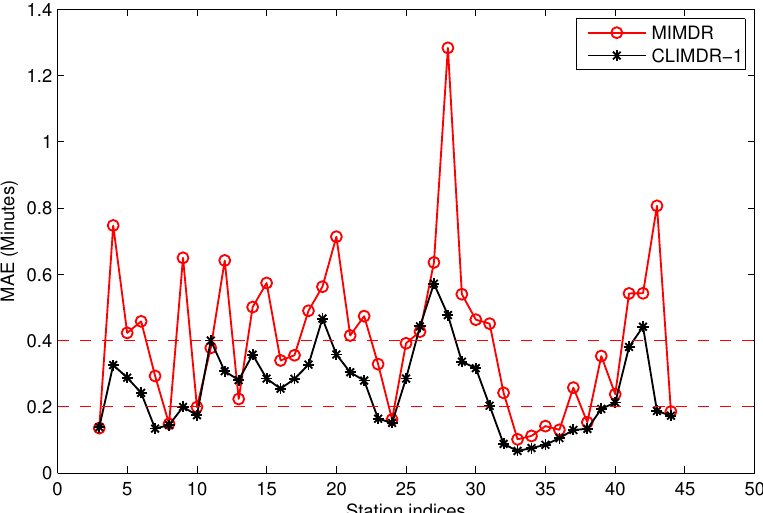
Figure 20. The MAE performance of the recovered data by median value interpolation for missing data recovery (MIMDR).